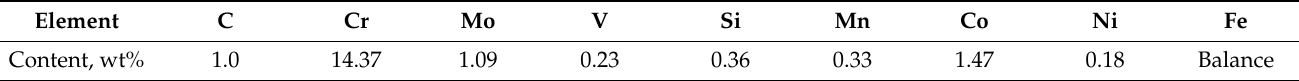
Table 1. Compositions of ESR electrode.